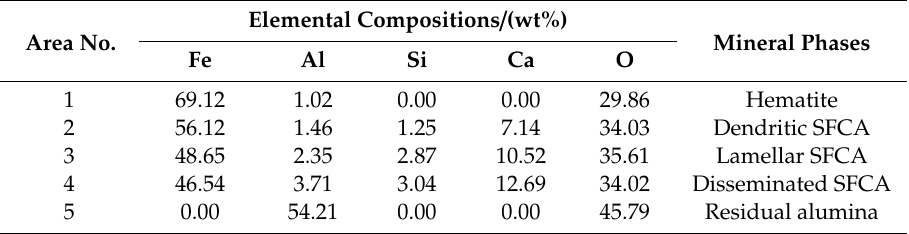
Figure 11. E ff ect of gibbsite on the characteristics of the bonding matrix (P: Pore; a → b: Rotate 90 ◦ to the right; ( a , b ) are the optical and SEM photographs of the reaction interface respectively; ( c ) is the photograph of line scan in ( b )). Table 6. EDS analysis results for areas in Figure